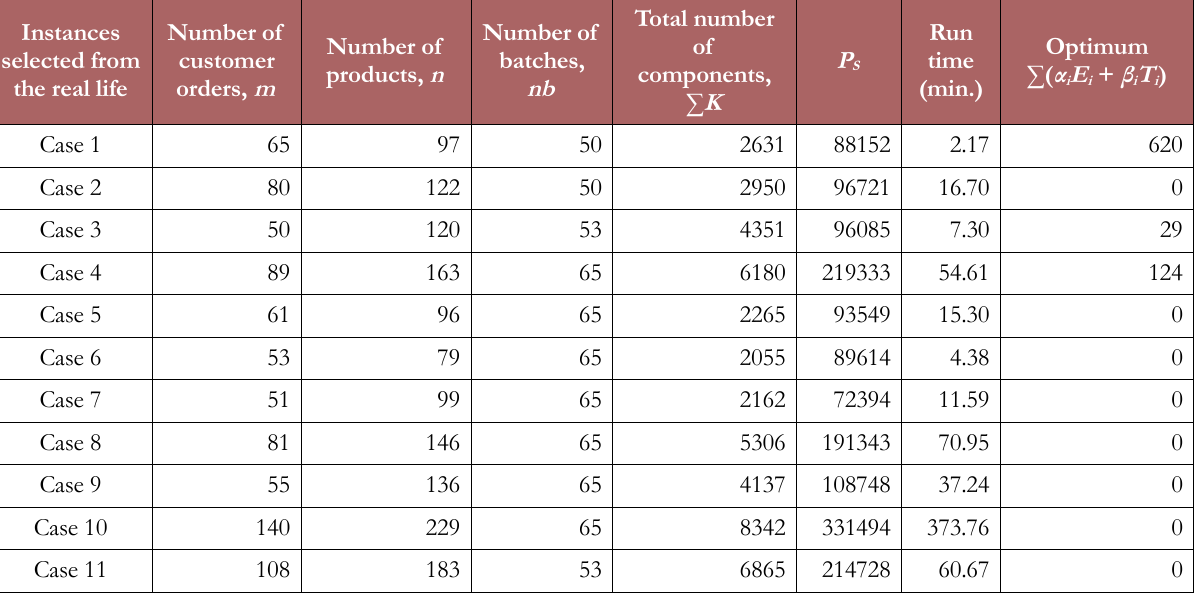
Table 4. Perfomance of Model-A on the real-world cases